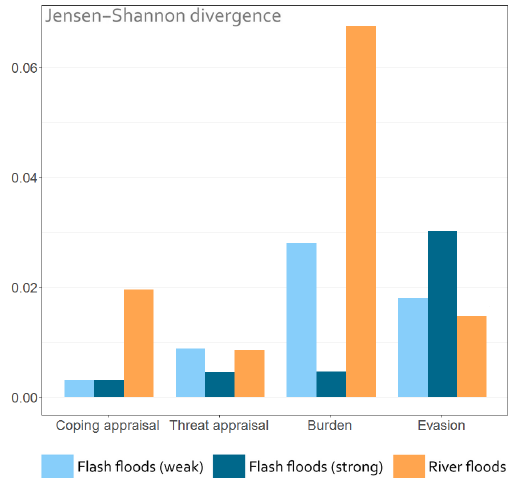
Figure 5. Jensen–Shannon divergence ranking of the psychological indicators. Higher values indicate a higher information gain, if the planned precaution is explained through the particular